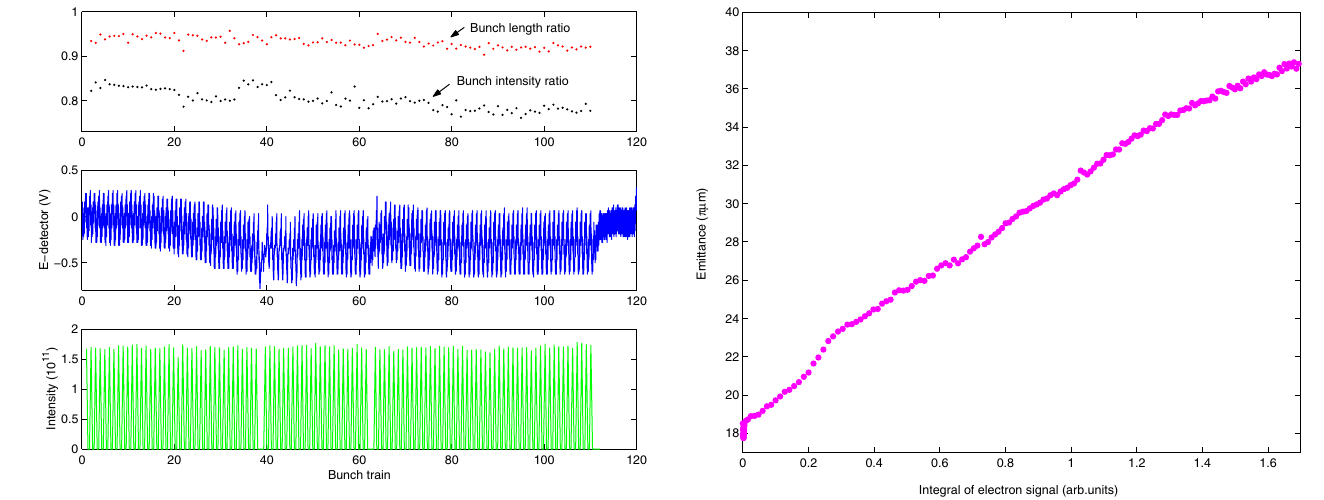
FIG. 12. (Color) The correlation of the Blue ring vertical emit- tance growth measured by the IPM and the integral of the electron signal detected by the vertical electron detector in the Blue ring section